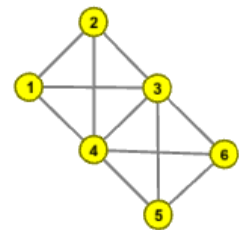
Figure 2. Example of Complete subgraph folding.